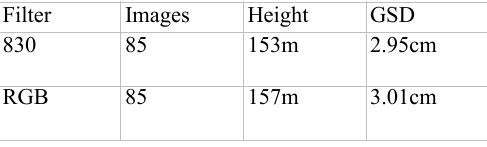
Table 1. UAV acquisition configuration